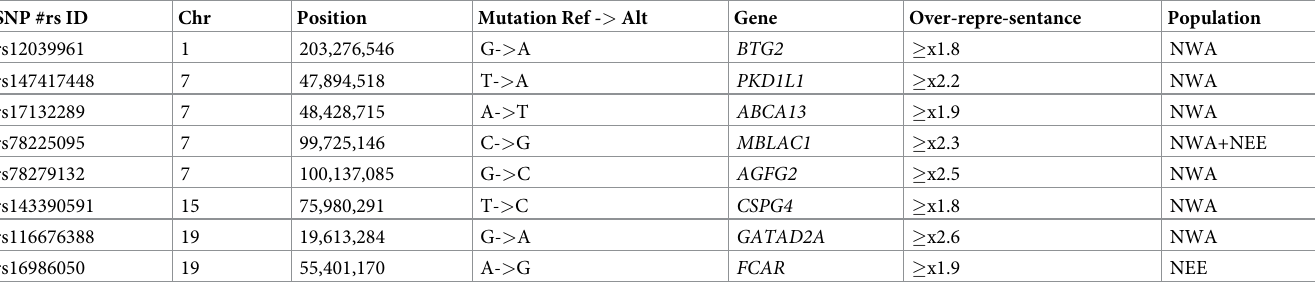
Table 5. List of most prominent missense mutations that are overrepresented in North